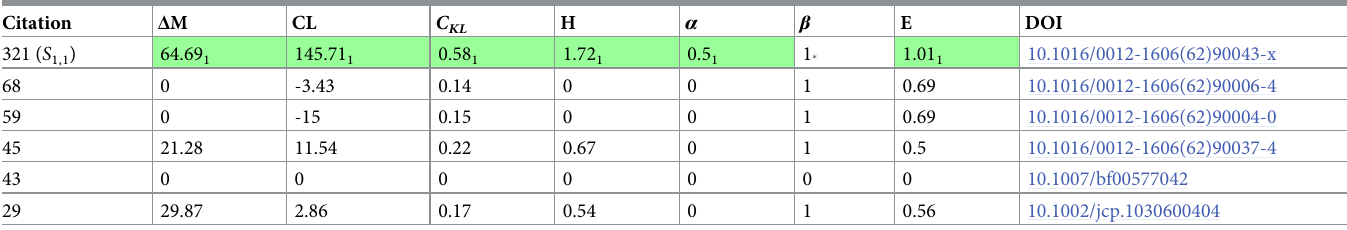
Table 3. Case 1. The SVA scores of top-6 most cited papers in the network (1957-1962). SVA score ranges: Δ M :0.0–64.69, CL :-15.00–145.71, C KL :0.0–0.58, H :0.0–1.72, α :0.0–0.5, β :0.0–1.0, E : 0.0–1.01. The subscript next to each SVA score of the seed paper indicates the paper’s relative rank according to that metric, sorted in a descending